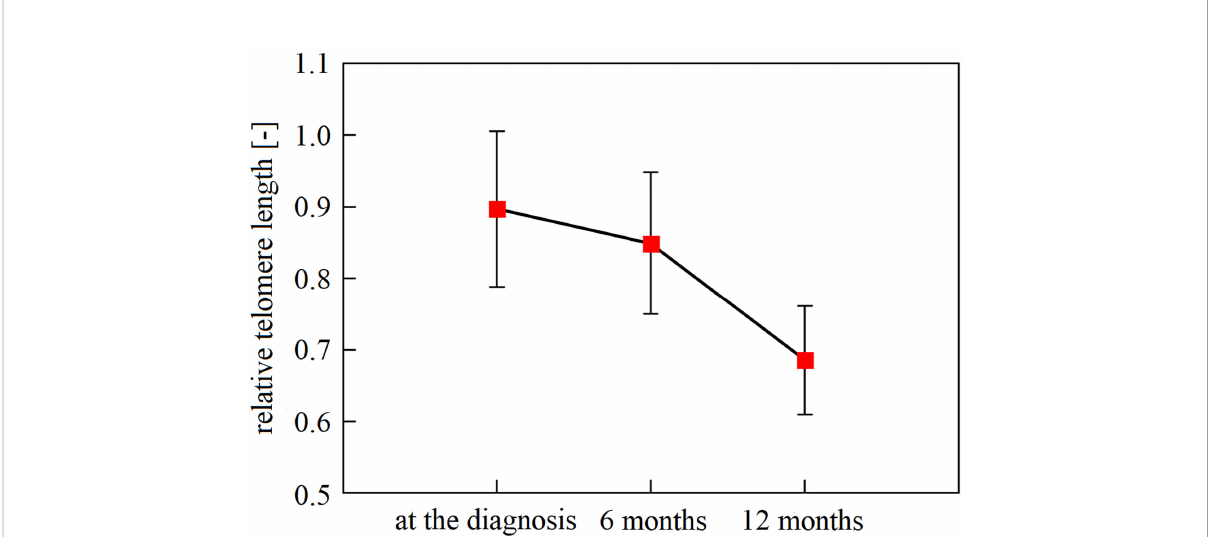
FIGURE 1 The downward trend in leukocyte telomere length of newly diagnosed patients within a 12-month interval. Mean LTL declined signi fi cantly over the recorded time points (p < 0.0001), with a gradual decline. With Bonferroni adjustment, patient leukocytes sampled at the time of diagnosis and in the following 6 months had longer telomeres than one year since diagnosis (n = 49, Bonferonni post-hoc test p ≤ 0.0001). Observation within 18 months could not be performed due to the paucity of samples taken 18 months after diagnosis (a complete number of blood samplings (at the diagnosis, 6 months, 12 months, and 18 months) has been accomplished only in 6 patients). Vertical bars denote 0.95% CI.